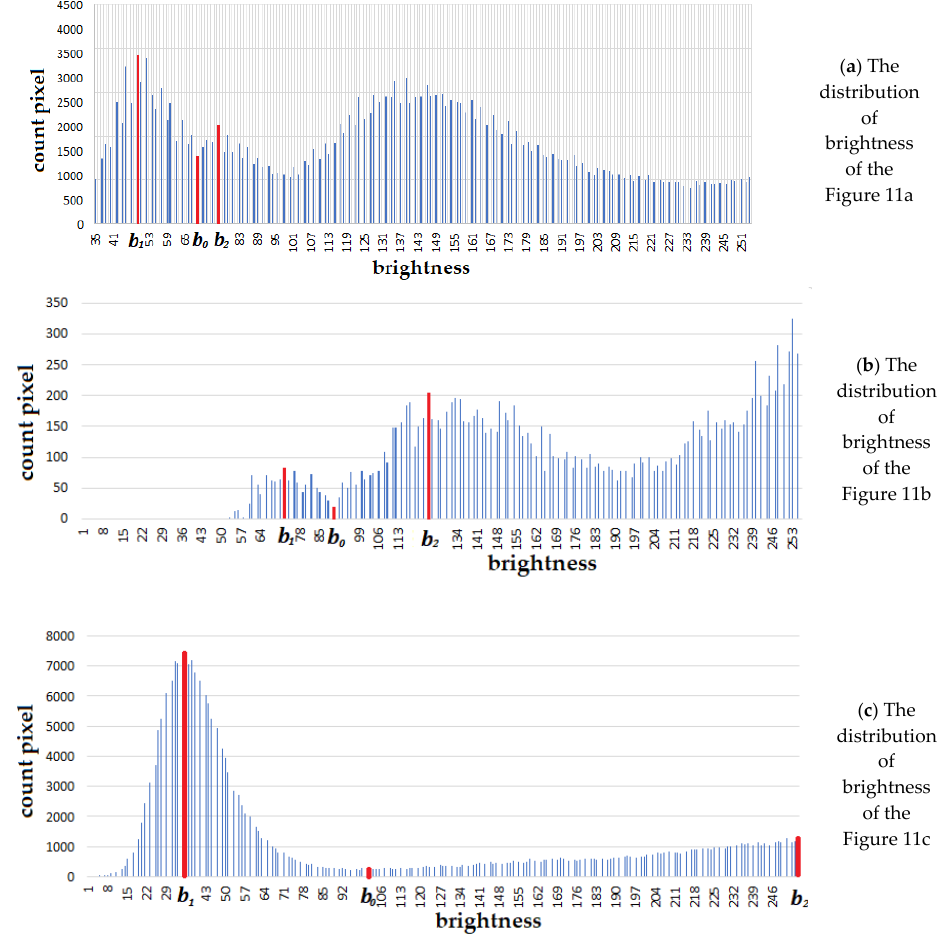
Figure 12. Histograms of the brightness distribution of pixels in the HSV space of the images in Figure 11 respectively.